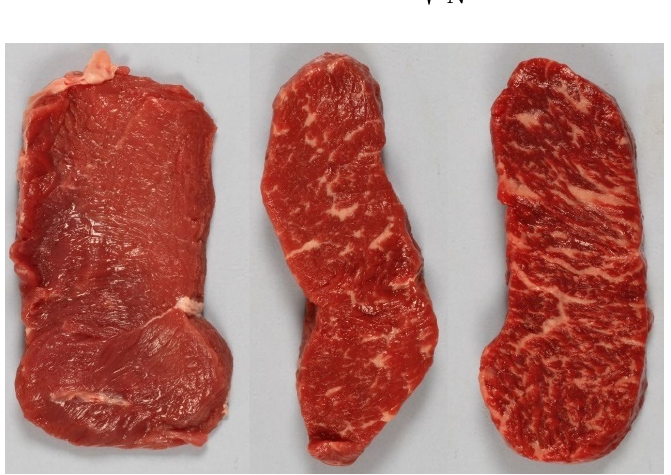
Figure 2. Reference slices for fat marbling. Scores 1 (left), 5 (middle) and 9 (right).